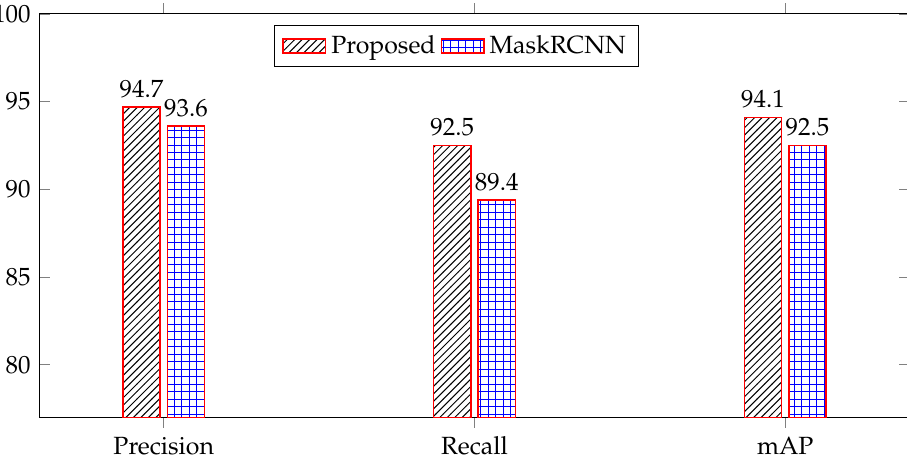
Figure 14. Precision, recall, and mAP results of Yolov5 and MaskRCNN